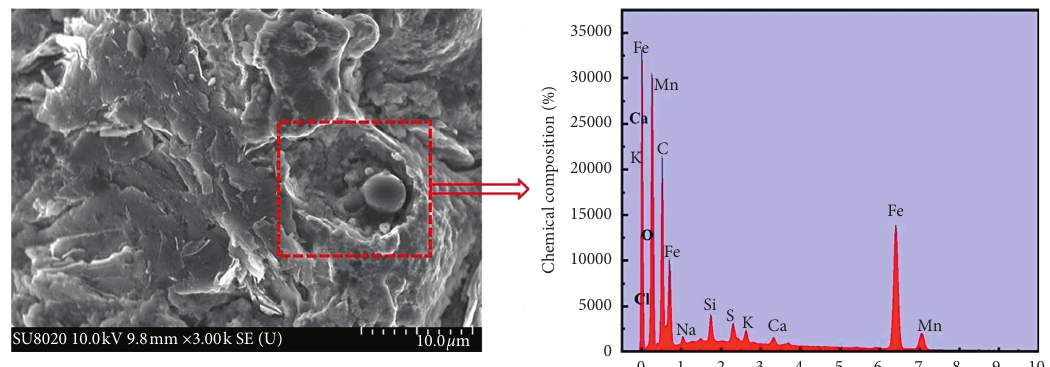
Figure 4: SEM micrograph and the corresponding XRD spectrum of the